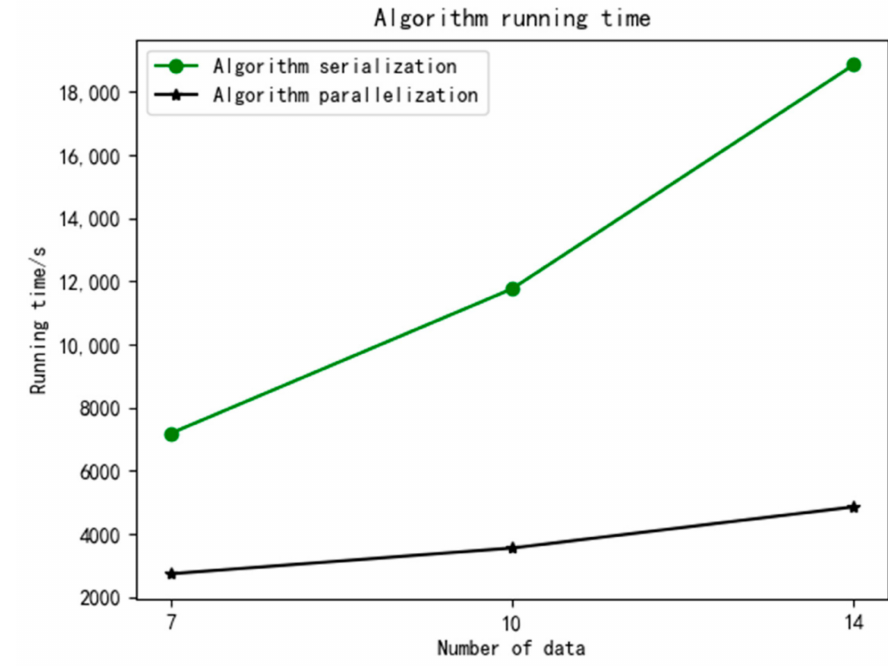
Figure 4. Algorithm running